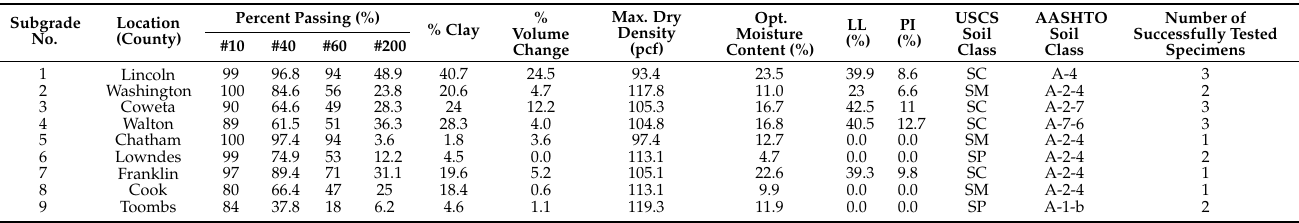
Table 1. Subgrade sources and properties